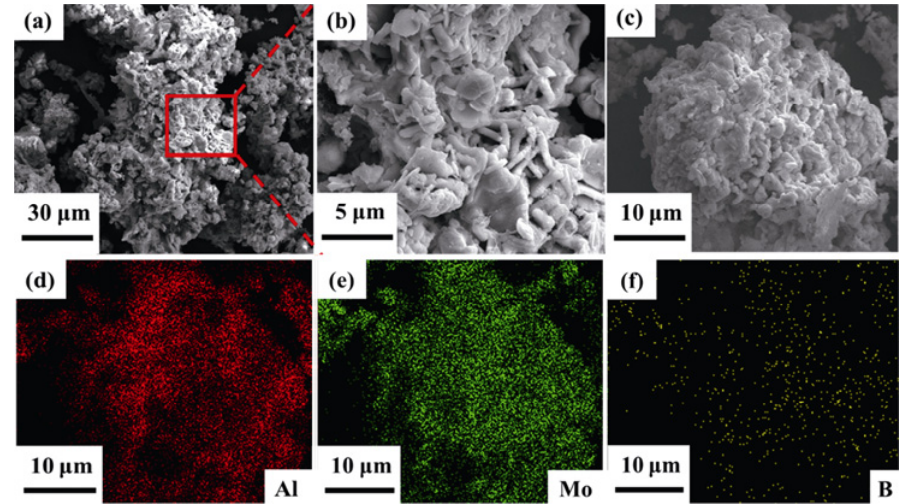
Fig. 3 (a) SEM image of the samples synthesized from 1Mo/1.3Al/1B by SHS and (b) higher magnification micrograph of the red area in (a); (c) SEM image of SHSed 1Mo/1.3Al/1B samples with elemental mappings of (d) Al, (e) Mo, and (f) B in